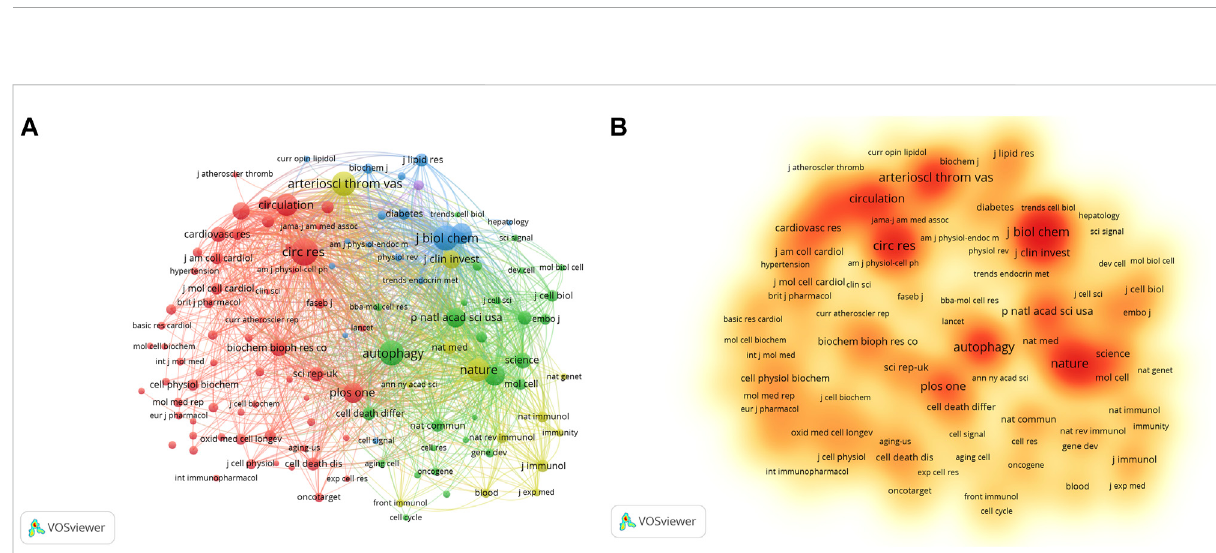
FIGURE 4 Analysis of co-cited journals based on VOSviewer visual map. (A) Network visualization; (B) Density visualization. Each node on the map is fi lled with a color based on the element density. Journals with high citation frequencies are indicated in